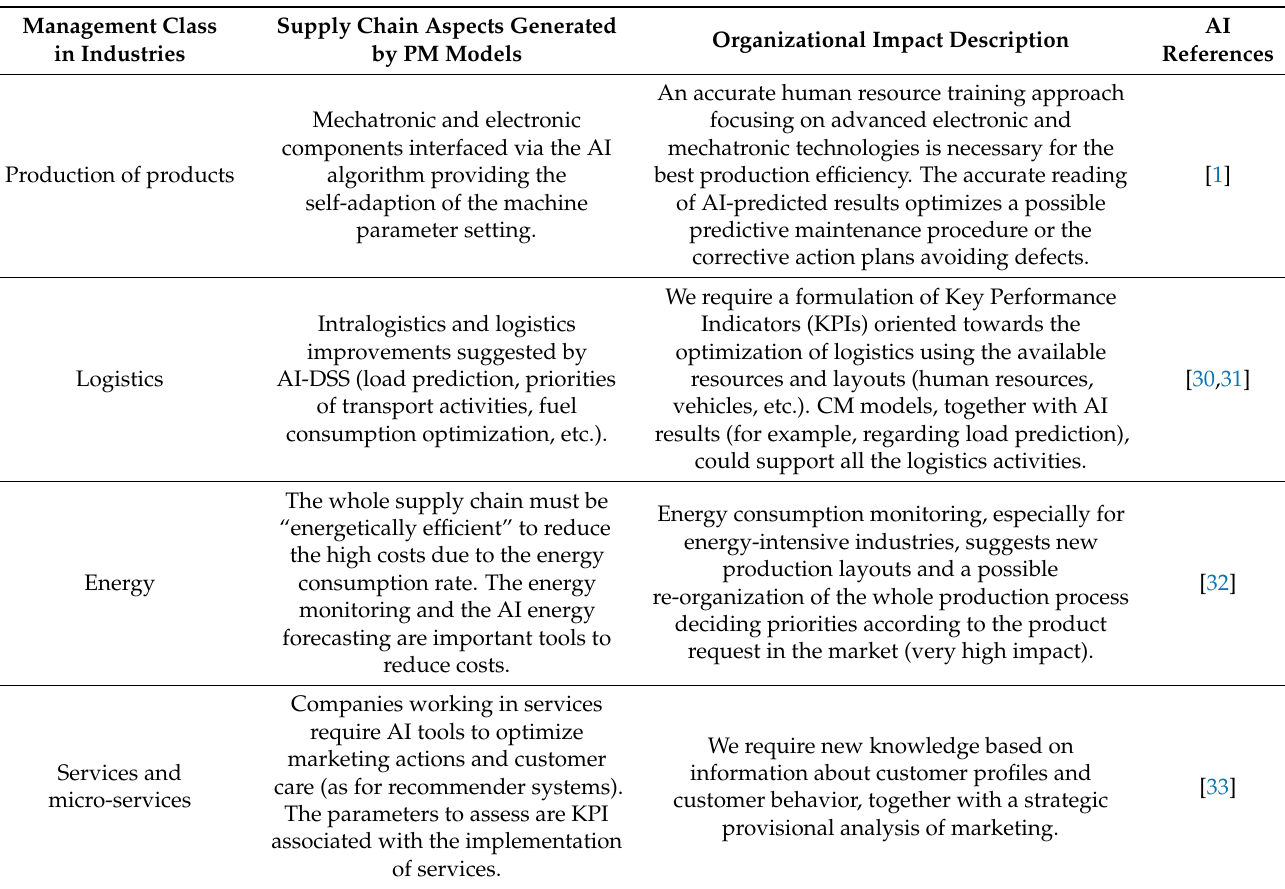
Table 2. Classes of management types and related PM-AI aspects in the supply chains and their organizational